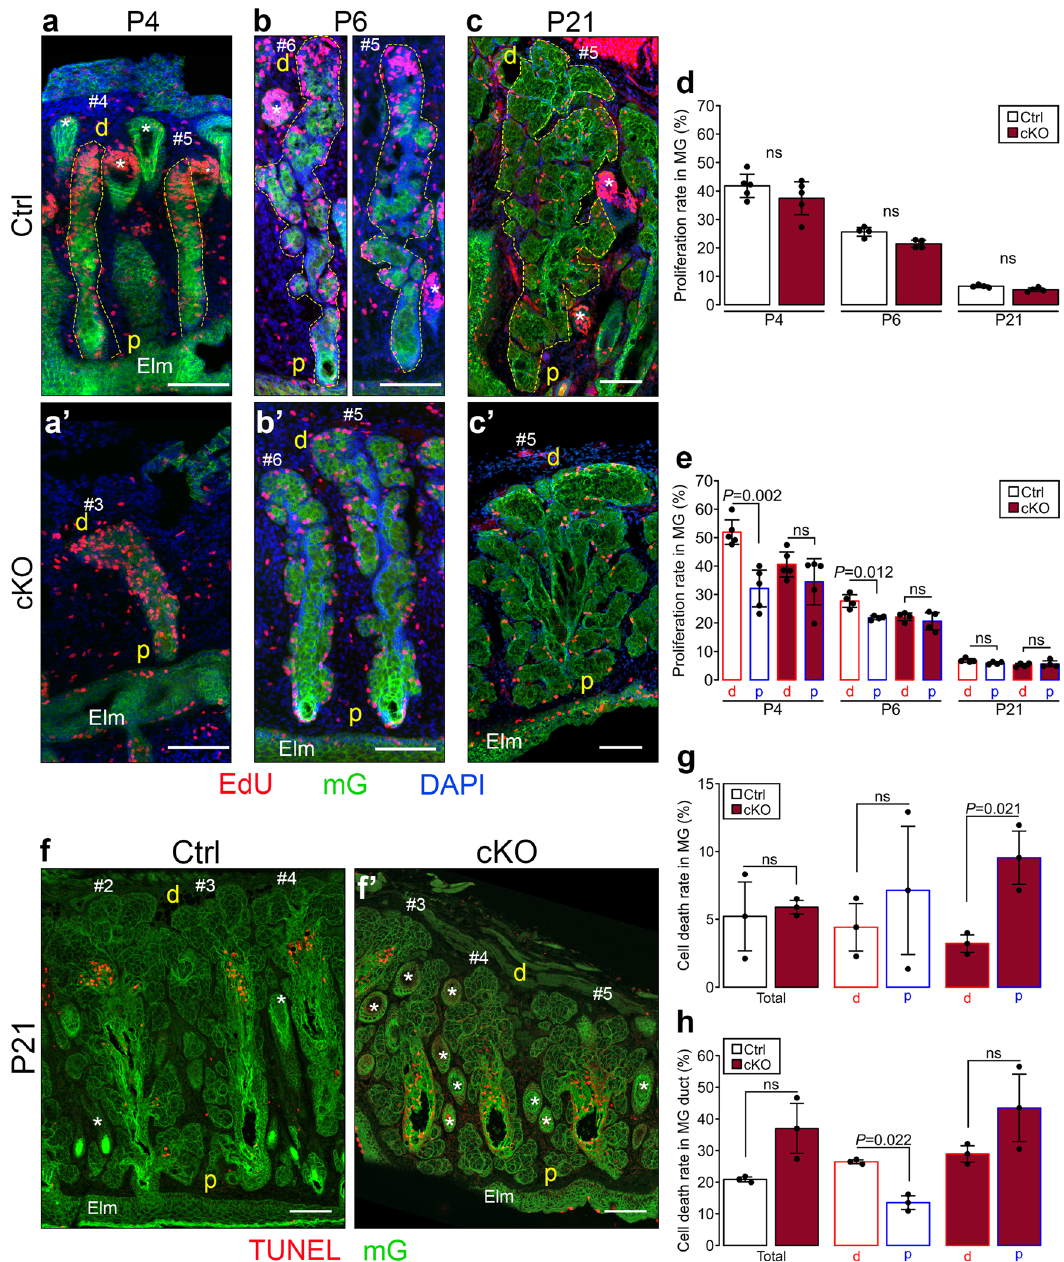
Fig. 4 Primary cilium ablation did not change the overall rates of proliferation and dying cells in MGs but led to an abnormal distal/proximal localization of the proliferating and dying cells within MGs. a – c Cell proliferation was assessed by EdU staining in MGs at P4, P6 and P21 in control ( a , b , and c ) and cKO ( a ’ , b ’ , and c ’ ) mice, respectively. Scale bar, 100 µ m; *, hair follicle; Elm, eyelid margin; d, distal; p, proximal. d – e Proliferation rates were quanti fi ed at P4, P6 and P21 in the full MGs ( d ), and speci fi cally in the proximal (p) half (from the eyelid margin to the center of the gland) and the distal (d) half (from the middle to the tip of the gland) of MGs e . Proliferation rates were determined by normalizing the number of EdU-positive nuclei to the total number of nuclei stained by DAPI ( n = 4/group). Data were presented as mean ± SD. Statistical signi fi cance was assessed using the Mann Whitney test (Ctrl vs. cKO) and Wilcoxon signed rank test (distal vs. proximal). ns, non-signi fi cant, P ≥ 0.05. ( f ) Cell death was assessed by TUNEL staining in MGs at P21 in control ( f ) and cKO ( f ’ ) mice, respectively. Scale bar, 100 µ m; *, hair follicle; Elm, eyelid margin; d, distal; p, proximal. ( g – h Cell death rates were quanti fi ed at P21 in the full MGs ( g ) and speci fi cally in the central duct ( h ). Cell death rates were determined by normalizing the number of TUNEL-positive nuclei to the total number of nuclei stained by DAPI (n = 3/group). Data were presented as mean ± SD. Statistical signi fi cance was assessed using the Mann-Whitney test (total, Ctrl vs. cKO) and Wilcoxon signed rank test (distal vs. proximal). ns, non-signi fi cant, P ≥